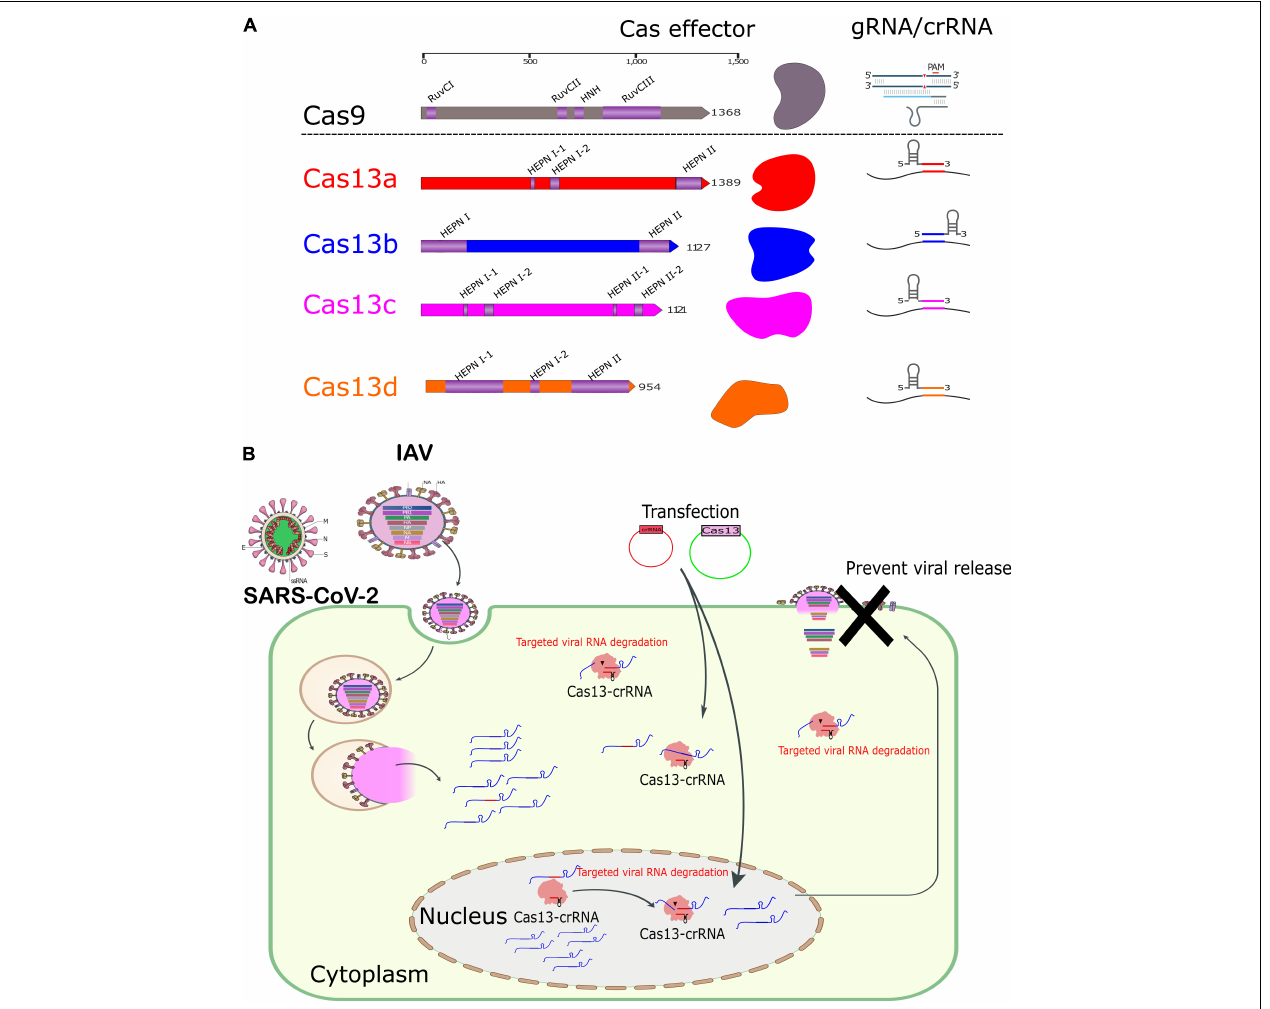
FIGURE 1 | Domain architectures of representative CRISPR effector proteins and RNA-mediated degradation of Cas13s. (A) Schematic representation showing the architecture of some proteins of class II CRISPR nucleases. The length of each protein is shown at the top scale. Schematic diagrams for gRNA and crRNAs of the Cas9 and Cas13, respectively, are indicated. (B) Schematic representation of the mechanism of action of RNA-mediated degradation of Cas13 nucleases in a cell